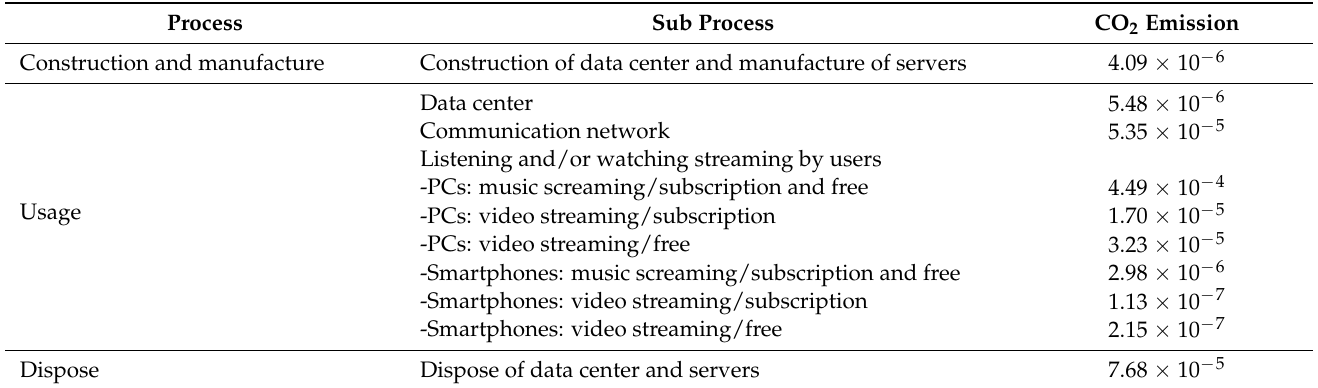
Table 5. CO 2 emission of each